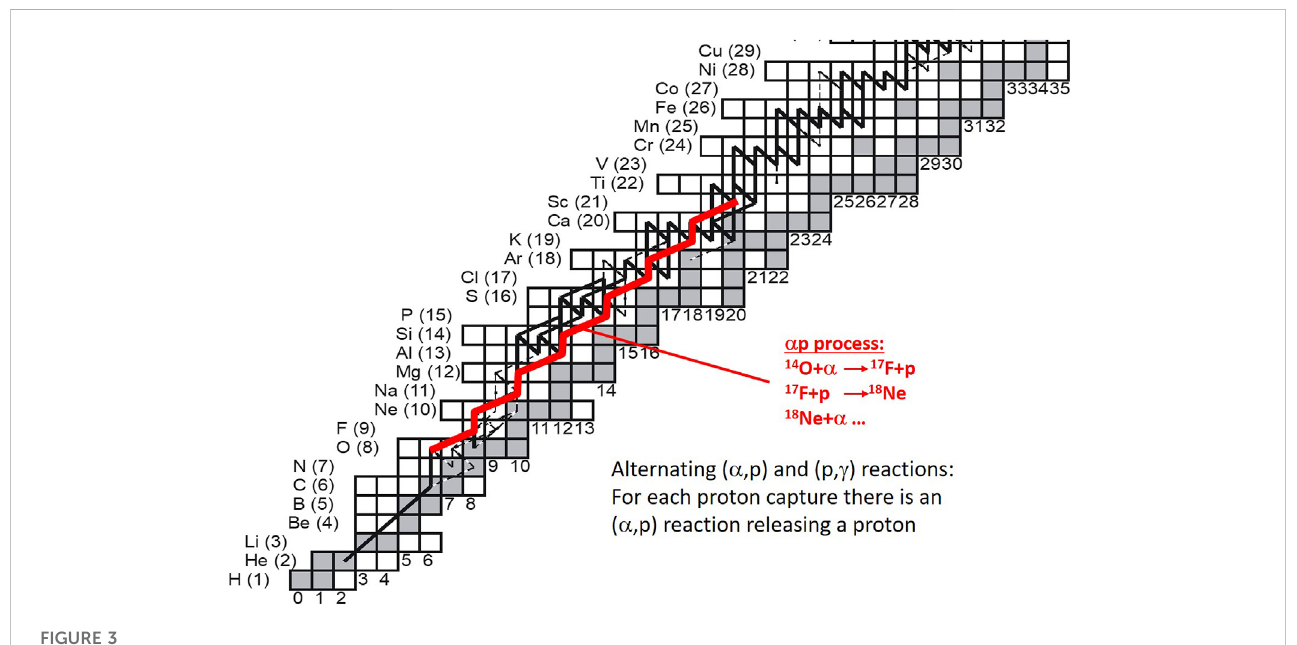
FIGURE 3 The α p process in an accreting neutron star